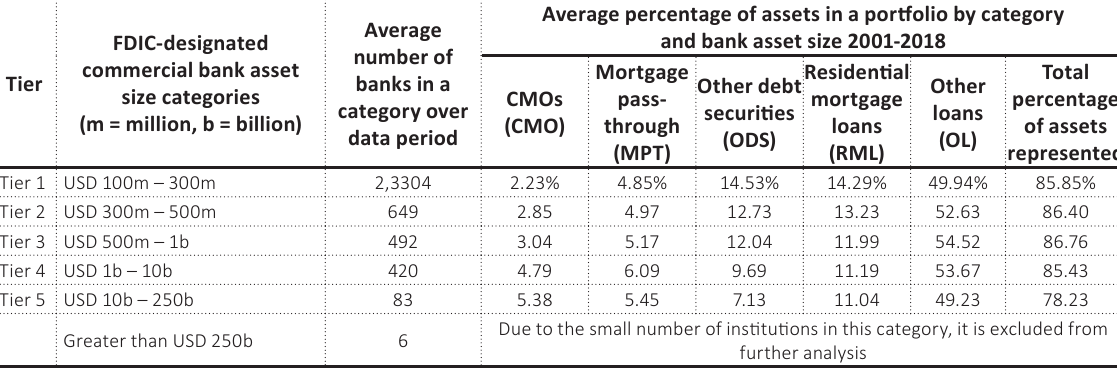
Table 2. Bank size designations, average number of institutions, and distribution of bank assets